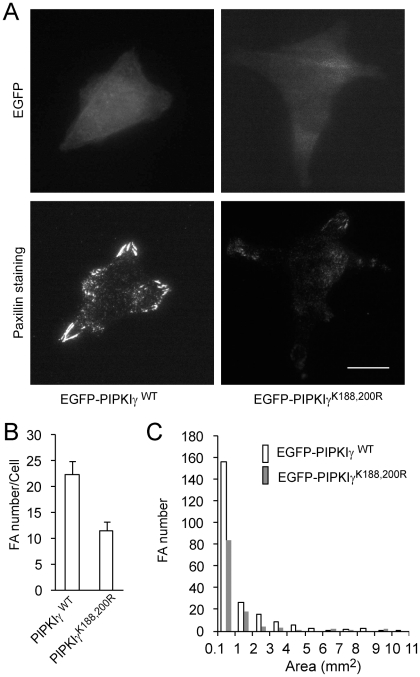
PIPKIγK188,200R was incapable of mediating focal adhesion formation in HCT116 cells.(A) TIRF images of CHO-K1 cells expressing PIPKIγ or PIPKIγK188,200R. Cells that stably express EGFP-PIPKIγ WT or -PIPKIγK188, 200R were stained for paxillin. Scale bar, 20 µm. (B) PIPKIγK188, 200R failed to stimulate an increase in focal adhesion number (n = 10, error bar = mean ± s.e.m; paired t-test, P<0.005). (C) Area distribution of focal adhesions in cells expressing PIPKIγ and PIPKIγK188,200R.